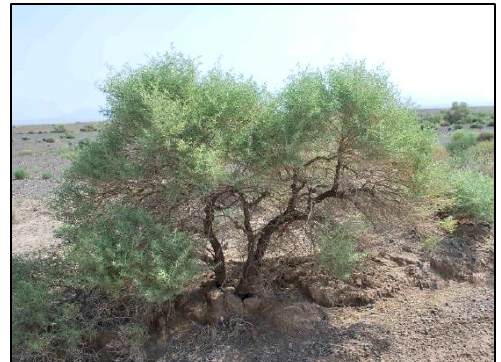
Figure 2. A multi-stem eshnan shrub in Qehi protected area.